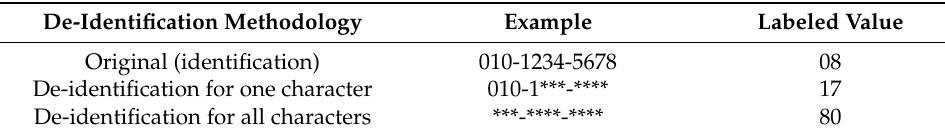
Table 3. Labeling rule for phone number. An asterisk (*) indicates a de-identified character from personal information.